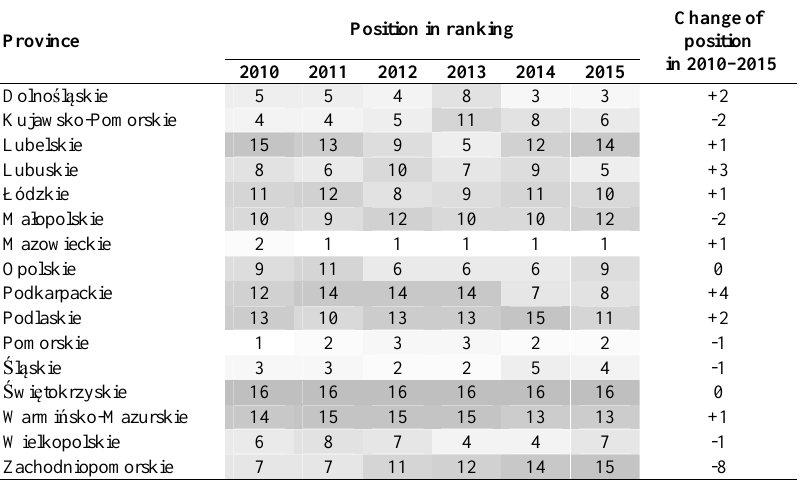
Table 3 . Ranking of provinces according to the synthetic ICT index between 2010 and